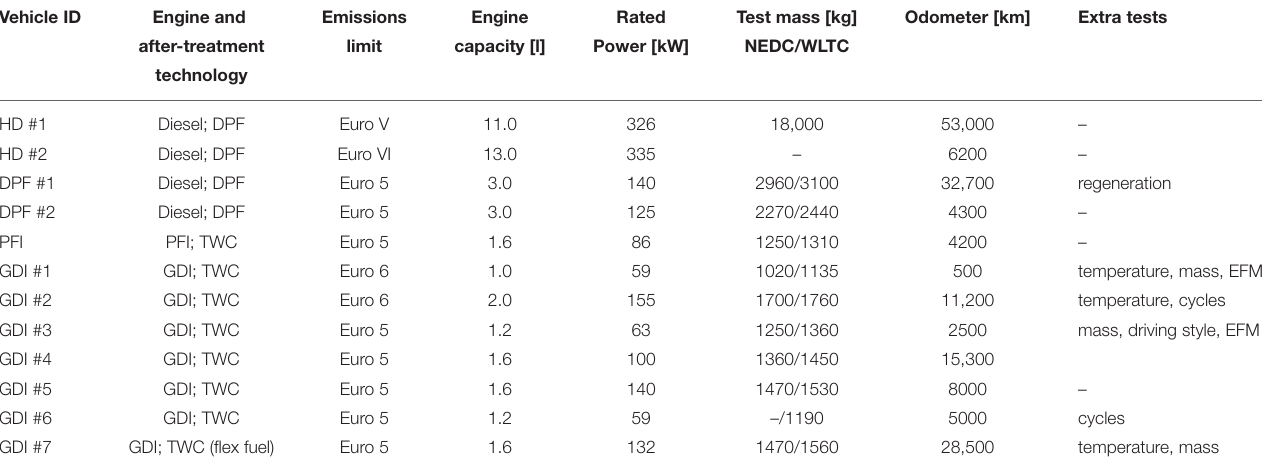
TABLE 1 | Characteristics of test vehicles and extra evaluation tests in the laboratory. Vehicle